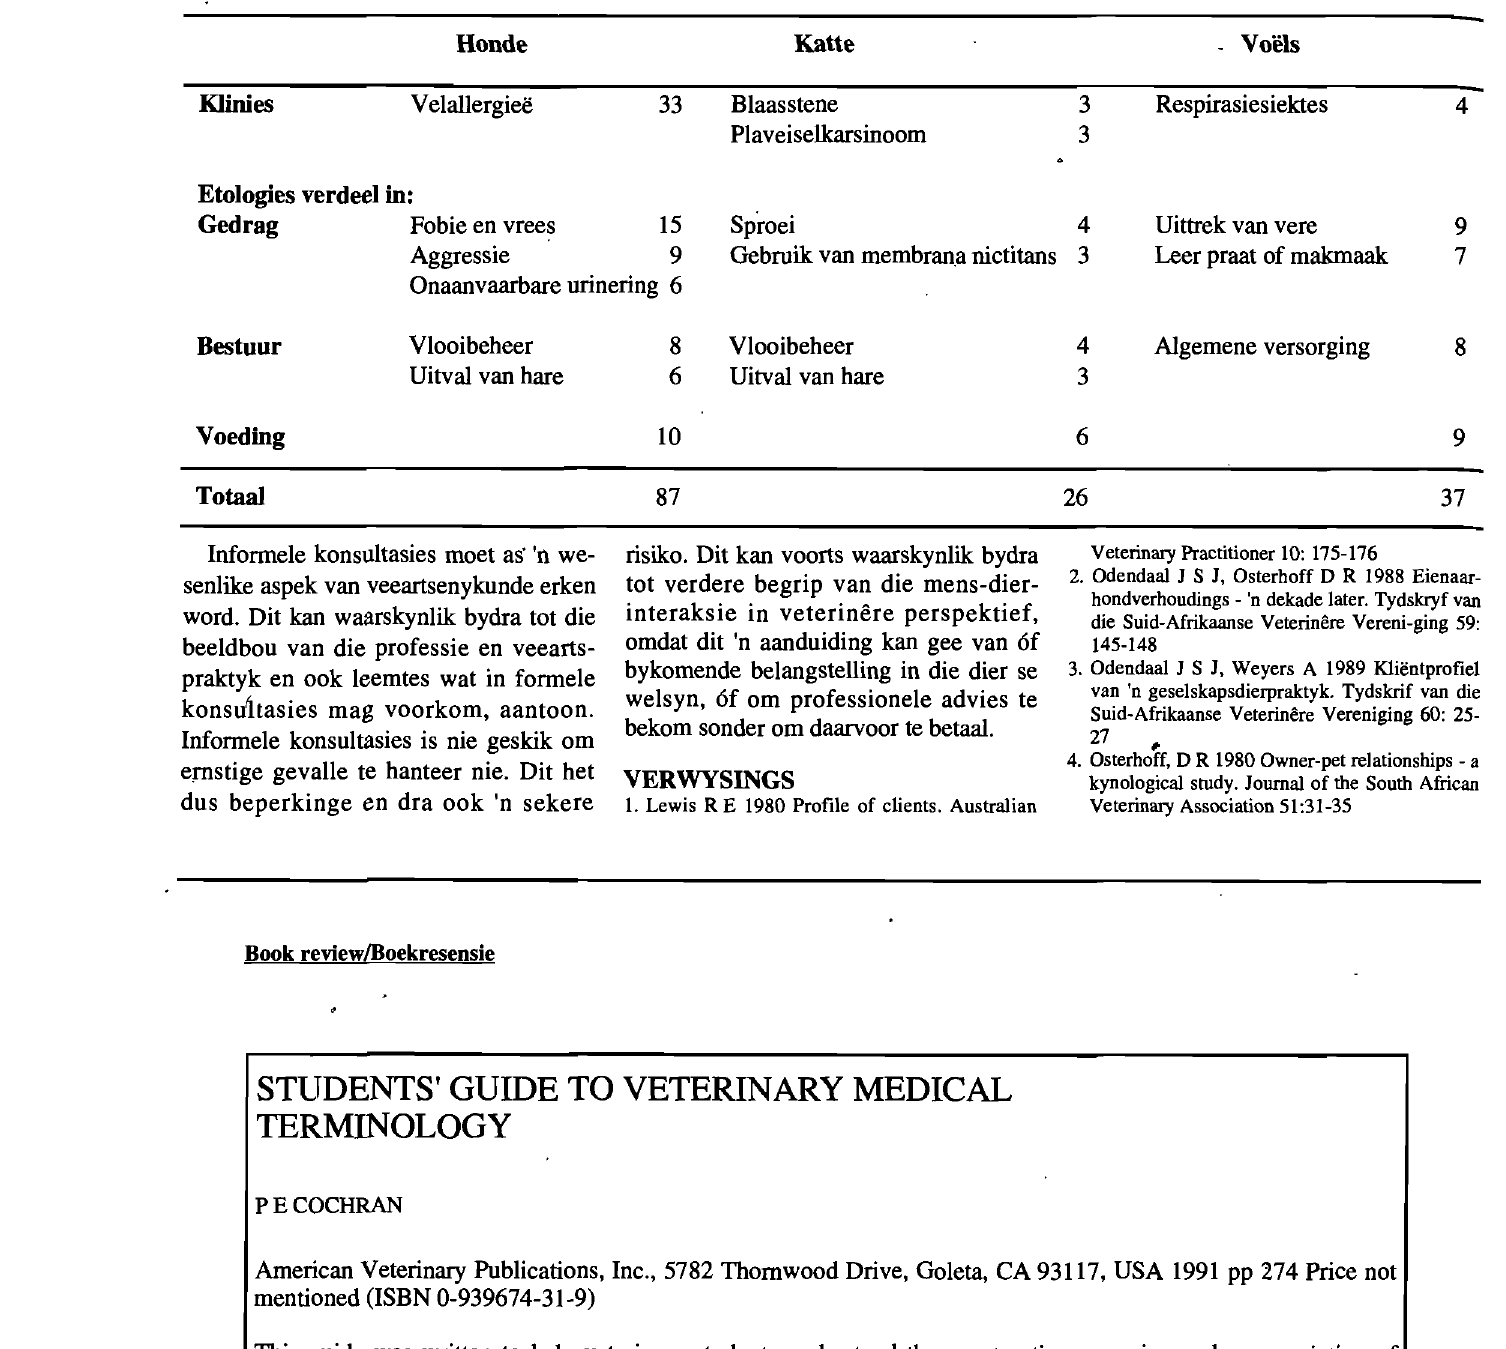
Tabel 3: Besonderhede van die inees aIgemene diagnoses onder honde, katte en voels tydens 'n radioprogramme oor